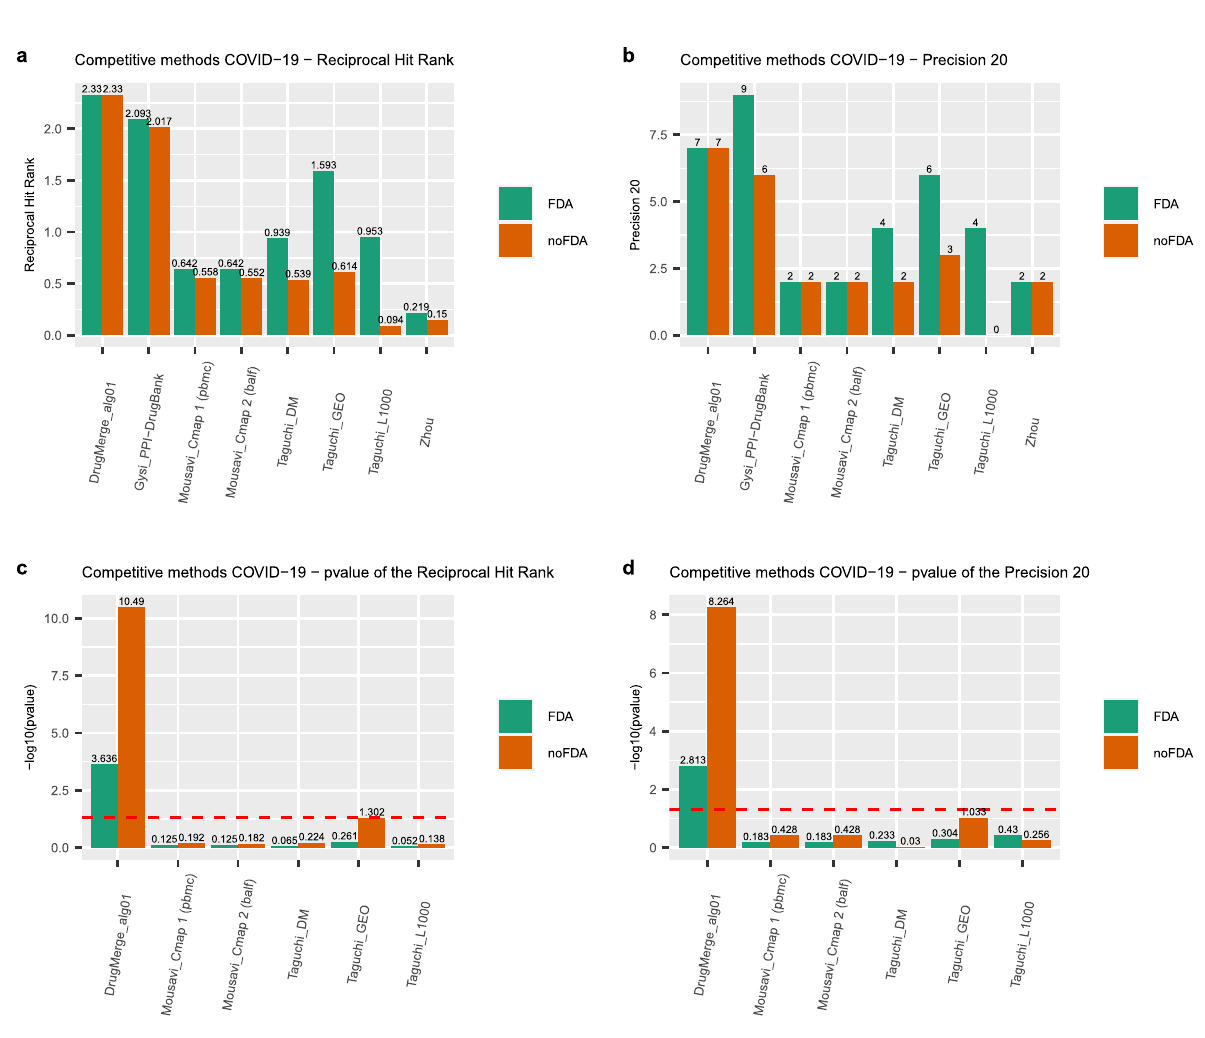
Figure 7. Performance of drug rankings reported in literature for COVID-19 drug repurposing. The ( a,b ) panels show the absolute values of RHR and precision 20, respectively. The ( c,d ) show the − log 10 ( p value ) of the RHR and precision 20, respectively. The dotted red line indicates the 0.05 significance threshold. The analyses have been performed using only FDA-approved drugs (green bars) and without any FDA filtering (red bars). The plot has been generated by the ggplot2 81 R